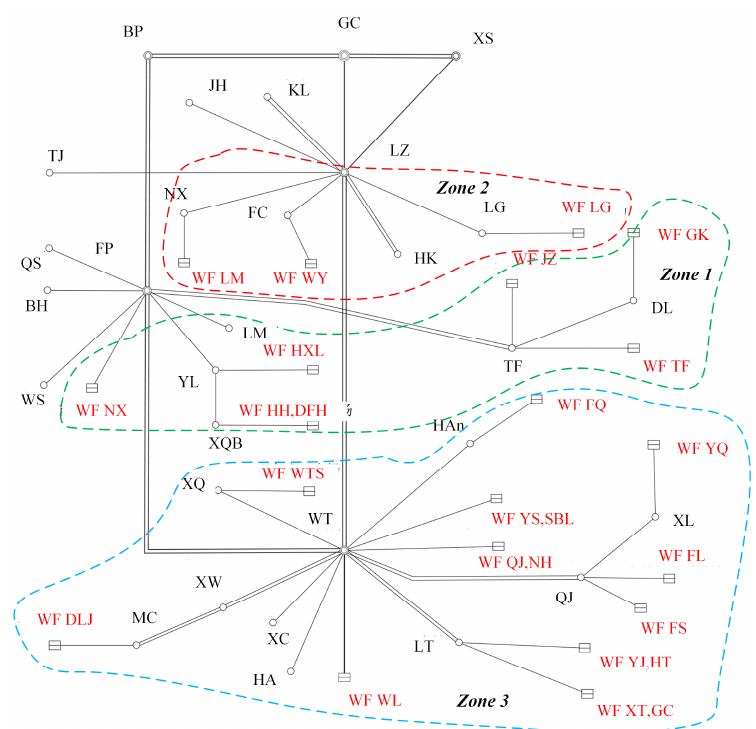
Figure 9. Structure of ZJ 110 kV and above power grid.